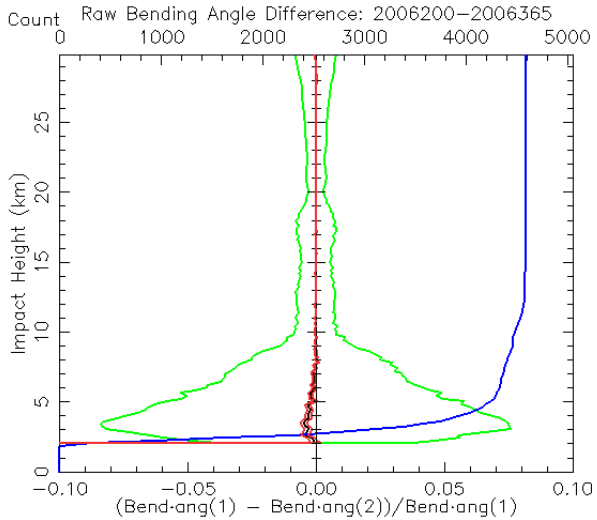
Fig. 20. This plot shows the mean, standard deviation, standard de- viation of the mean, and number of samples as a function of impact height for fractional differences between FM3 and FM4 bending angles globally in the lower troposphere from 2006.200-365.